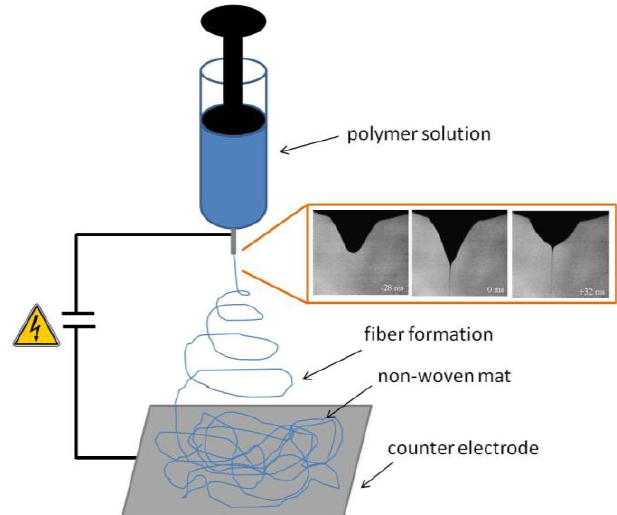
Figure 1. Sketch of a typical laboratory electrospinning setup; in the inset, frames from a potential. Adapted with permission from [26]. Copyright (2008) by